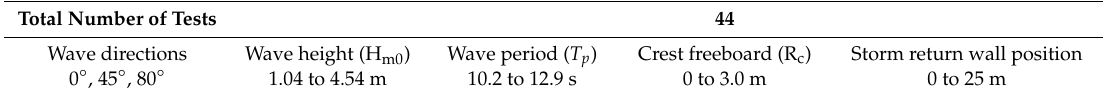
Table 4. Summary of the test conditions for the force